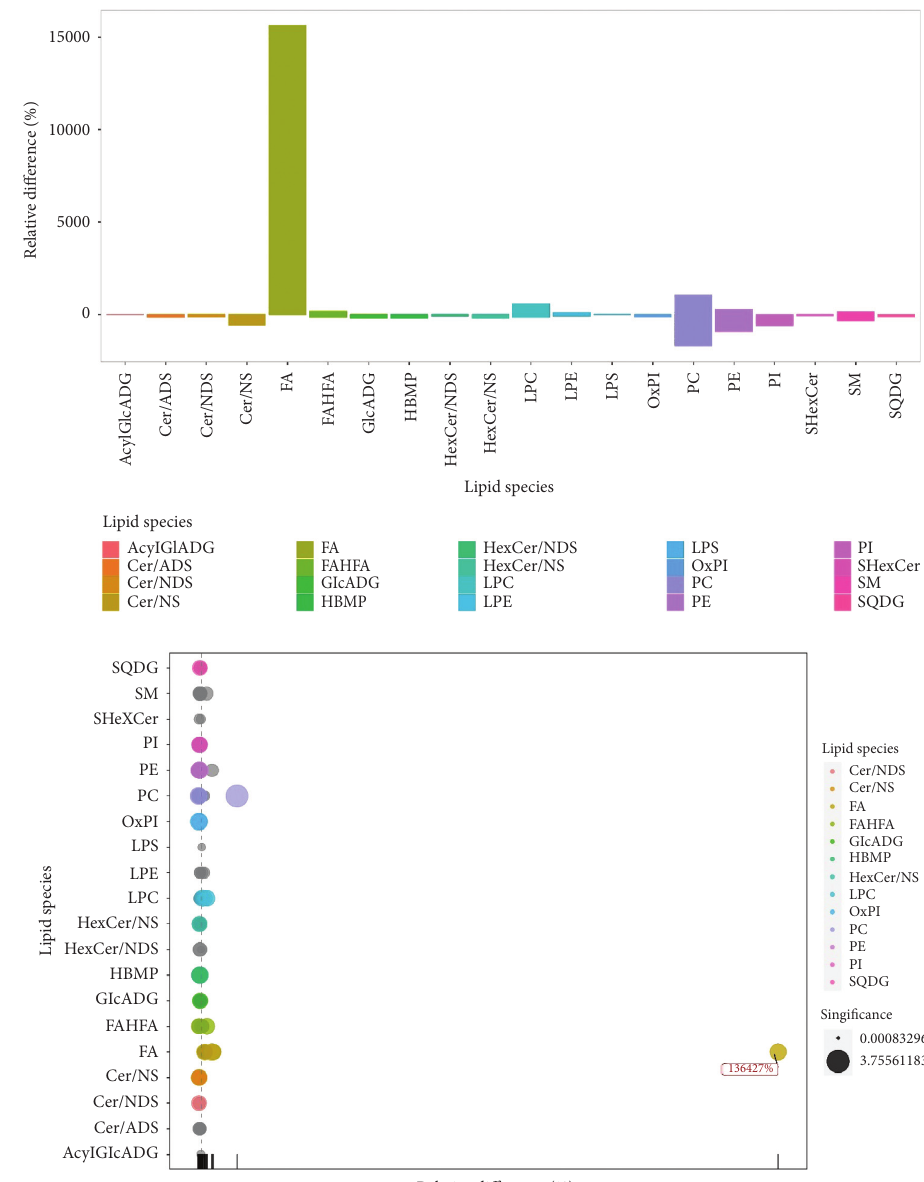
Figure 6: Histogram and bubble plot of lipid group in high-fat feed group-high-dose reconstituted rice group (negative ion